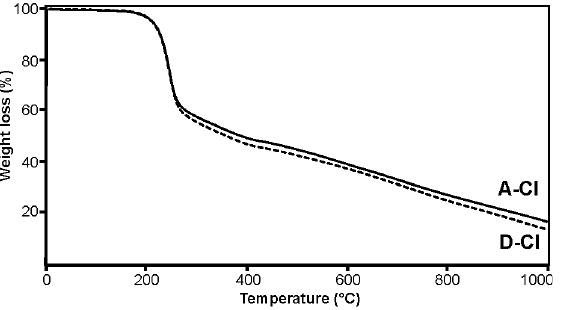
Figure 4. The thermogravimetric analysis (TG) of the materials A_ClPh and D_ClPh coated with chloramphenicol.